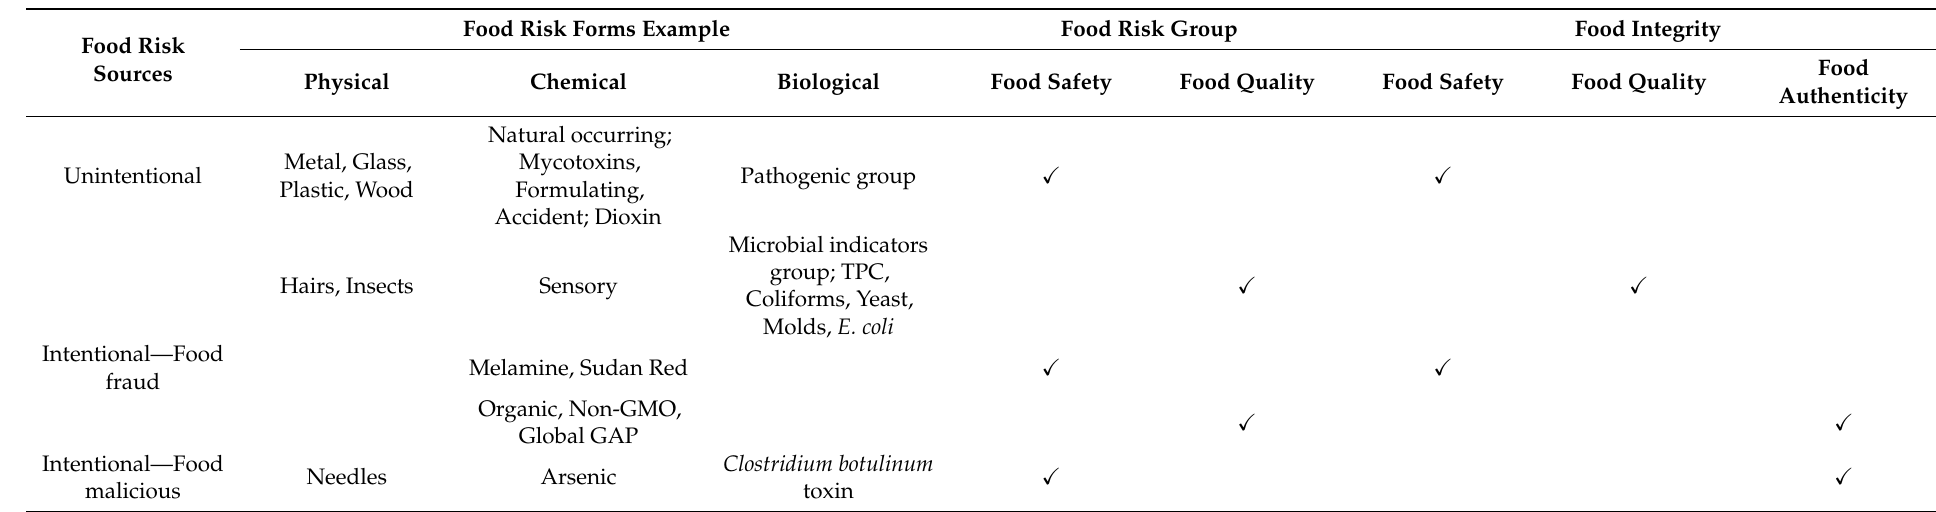
Table 2. Basic food risk